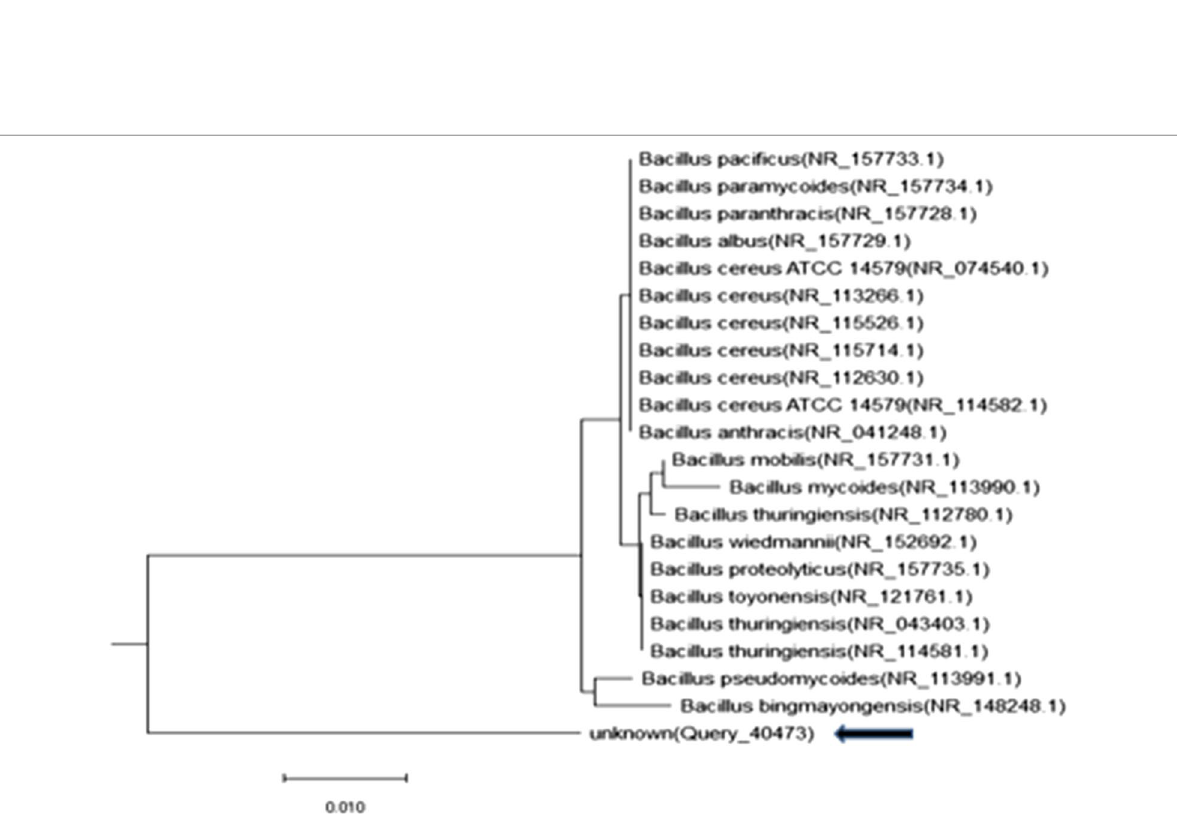
Fig. 3 Phylogenetic dendrogram obtained by distance matrix analysis of 16S rRNA sequences, showing the position of (B2) Bacillus paramycoides among phylogenetic